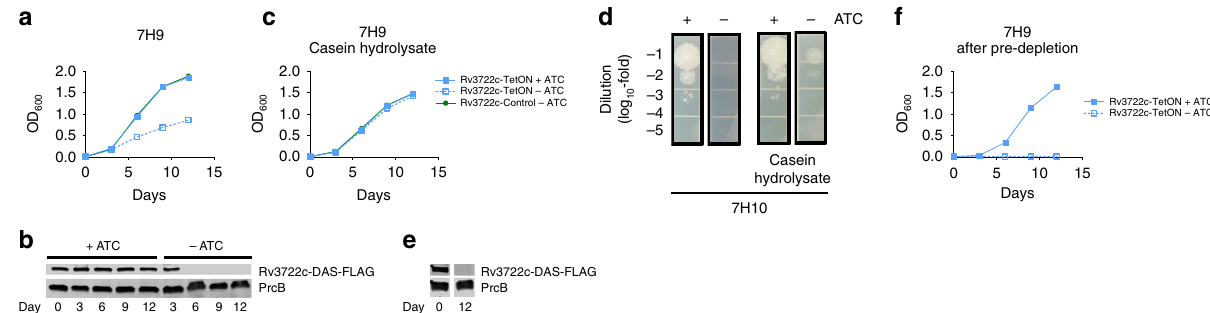
Fig. 1 Rv3722c is conditionally esssential in vitro. a Growth curve of Rv3722c-pro fi cient and -de fi cient Mtb in 7H9 culture media. Rv3722c-TetON and Rv3722c-control were cultured in Middlebrook 7H9 culture media, with or without 500 ng mL − 1 anhydrotetracycline (ATC). Bacterial growth was monitored by optical density at 600 nm. b Western blot showing the depletion of Rv3722c 7H9 culture media. Rv3722c-TetON was cultured in 7H9 with or without ATC for 12 days (corresponding to a ). Protein lysates were analyzed by western blotting, using an α -FLAG antibody. The proteasome subunit β (PrcB) was used as loading control. c Growth curve of Rv3722c-pro fi cient and -de fi cient Mtb in 7H9 supplemented with casein hydrolysate. As a , but using 7H9 supplemented with 1% casein hydrolysate. d Spot assay of Rv3722c-pro fi cient and -de fi cient Mtb on solid growth media. A serially diluted Rv3722c- TetON culture (OD 0.1) was spotted onto Middlebrook 7H10 agar with or without 1% casein hydrolysate, in the presence or absence of ATC, and cultured for 2 weeks. e Western blot showing depletion of Rv3722c. As b , but in 7H9 supplemented with 1% casein hydrolysate. f Growth curve of Rv3722c- pro fi cient and -pre-depleted Mtb in 7H9 growth media. Rv3722c-TetON in 7H9 with or without ATC, after predepletion of Rv3722c in 7H9 with 1% casein hydrolysate without ATC. For all growth curves, data are represented as mean − / + SD of three experimental replicates ( n = 3) representative of at least two independent experiments. See also Supplementary Fig. 1. Source data are provided as a Source Data fi le.